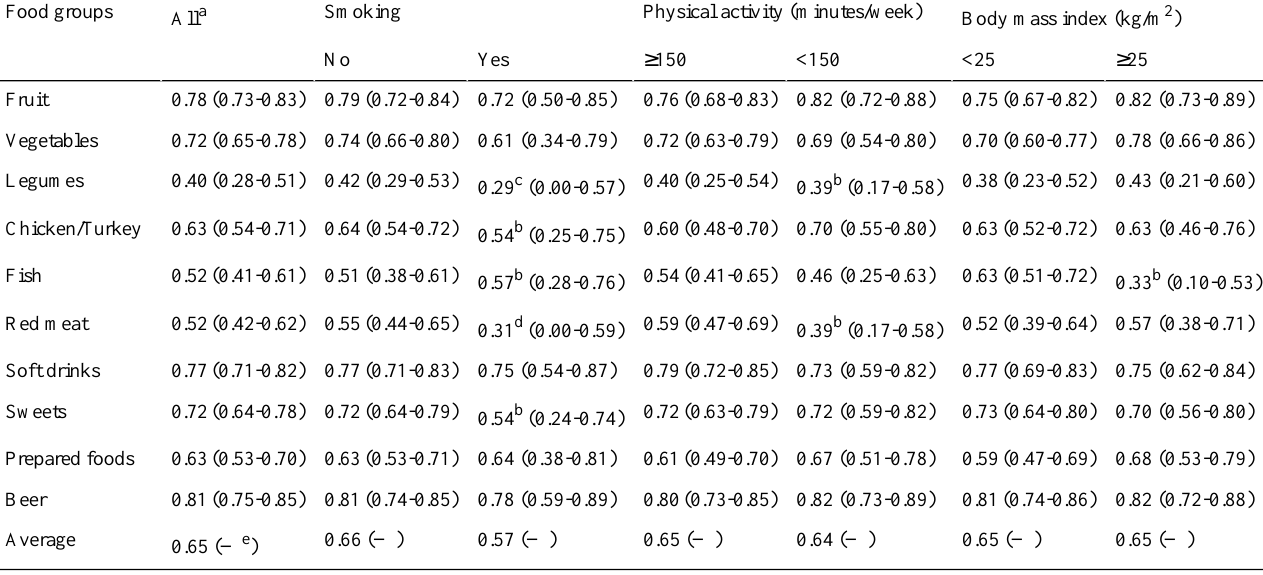
Table 9. Spearman correlation coefficients derived from the electronic 12-hour dietary recall app versus the 4 dietary records for categories of food group consumption and strata: smoking: no and yes; physical activity (minutes/week): ≥ 150 and <150; and body mass index (kg/m 2 ): <25 and ≥ 25. Comparison of the electronic 12-hour dietary recall app versus dietary records. Spearman correlation coefficients (95% CI).